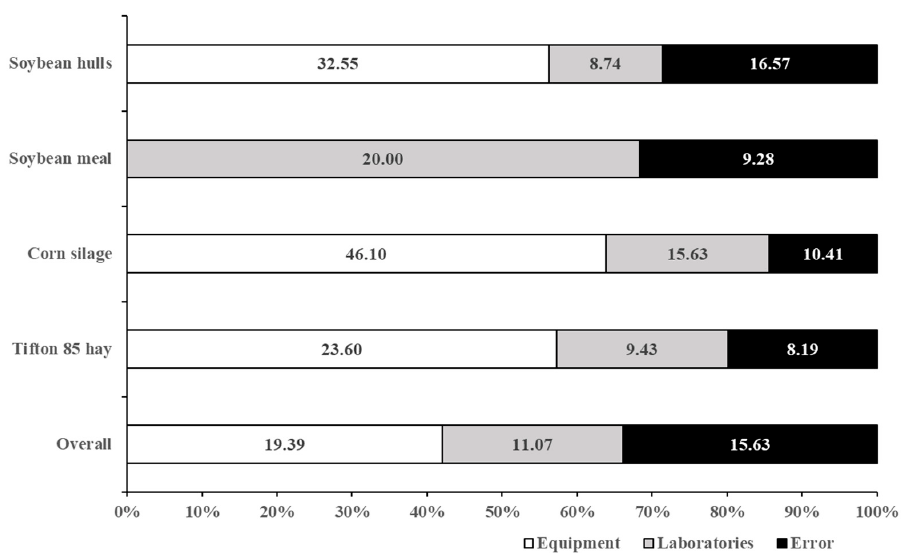
Figure 4. Comparative evaluation between variances of the in vitro dry matter digestibility associated with equipment type, laboratory, and error (between replicates) effects, according to different evaluated feeds (data label values are expressed as squared percentage units).